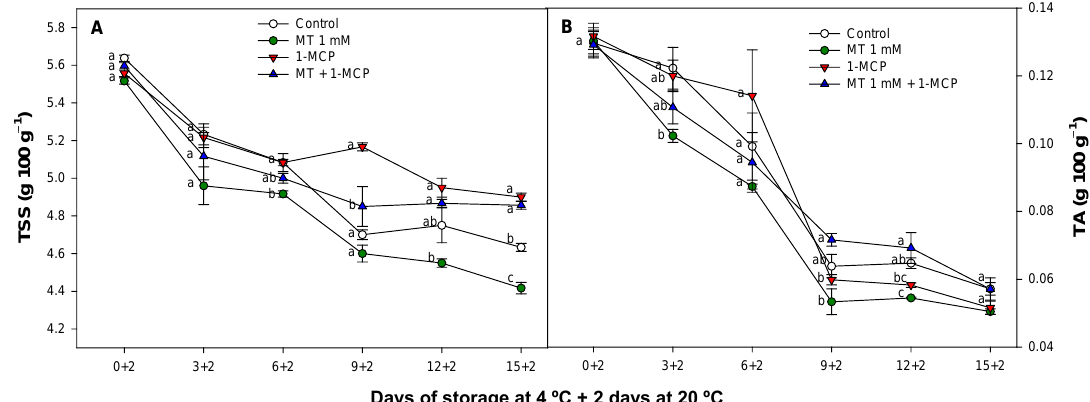
Figure 6. Evolution of total soluble solids (g 100 g − 1 ) ( A ) and titratable acitidity (g 100 g − 1 ) ( B ) of ‘Cronos’ zucchini fruit treated with melatonin at 1 mM (MT) or distilled water (Control) with or without 1-MCP during cold storage and after cold storage plus 2 days at 20 °C. Data are the mean ± SE (n = 3). Different lowercase letters show significant differences ( p < 0.05) among treatments for each sampling date.